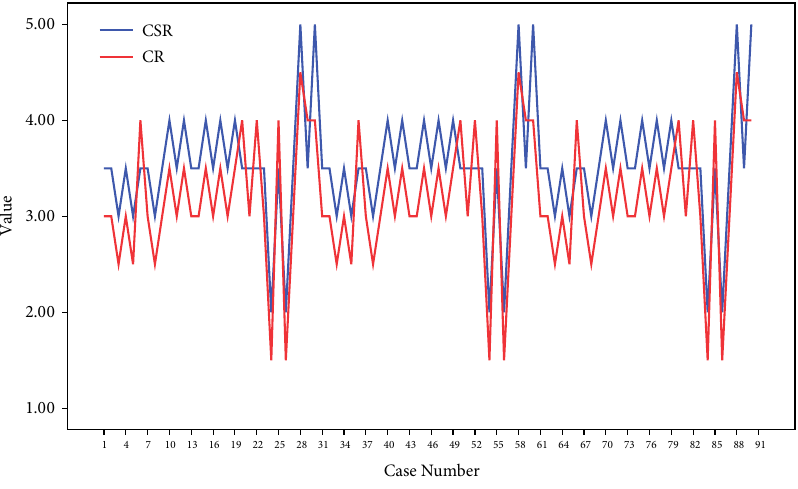
Case Figure 10. CSR – CR relation in Case SLO